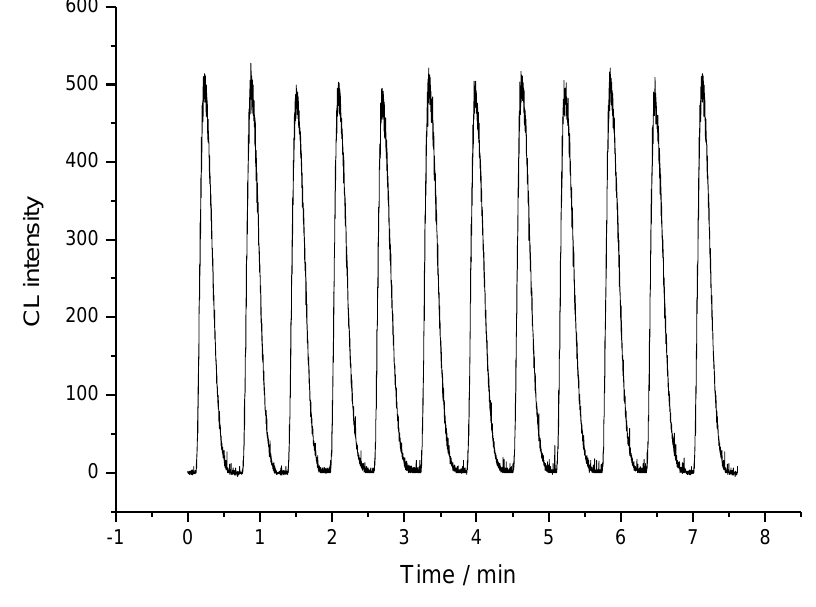
Figure 5. The CL intensity of 0.5 mM luminol + 4 mM H concentration of 0 ng/mL after regeneration of the immunoaffinity reactor by 10 mM